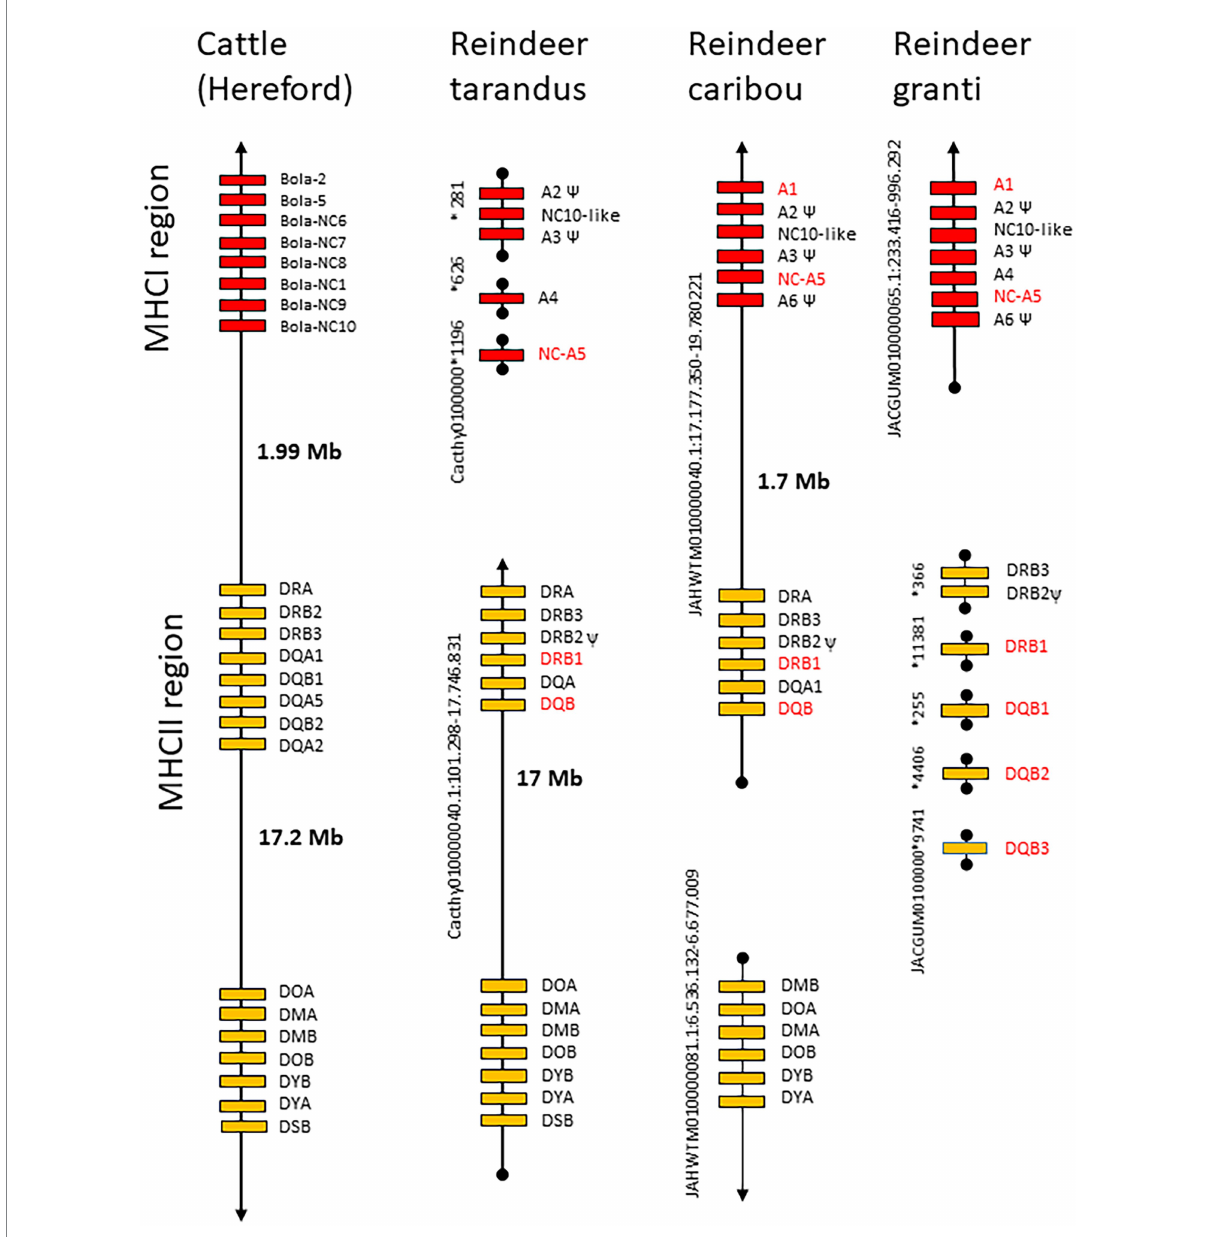
FIGURE 4 Genomic organization of reindeer and cattle MHC regions. The genomic organization of MHCI and MHCII genes in cattle (Hereford breed) and reindeer (tarandus, caribou and granti). Chromosomal location of each region is shown on the left-hand side of each region, where entire scaffold numbers for granti and tarandus can be found in Supplementary data 4. Genes are color shaded as follows: red boxes are MHCI genes, orange boxes are MHCII genes. Gene names in red font show the genes included in our study. Black lines with arrow indicate chromosomal regions, while black line with circles indicate scaffold. NCBI accession numbers for the genomes are as follows: cattle GCA_002263795.1, tarandus GCA_902712895.1, caribou GCA_019903745.1 and granti